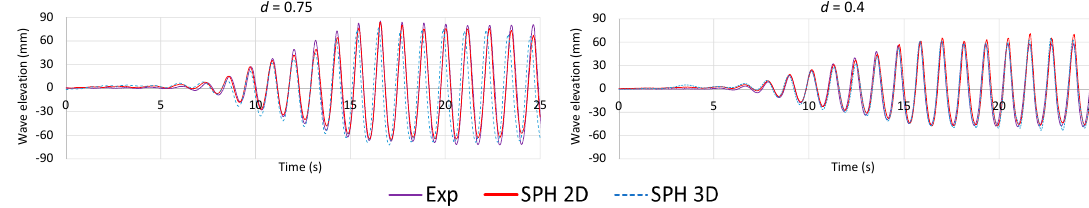
Figure 20. Comparison of wave elevation of the experiment, 2-D and 3-D SPH for A = 50.5 mm and T = 1.15 s.